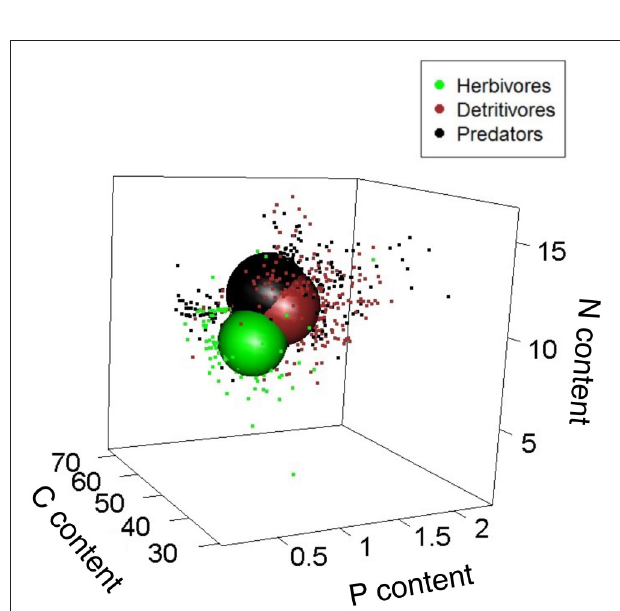
FIGURE 5 | Relative size of stoichiometric niche volumes of trophic groups (only invertebrates included). Sphere sizes depicts the volumes of the various grouping variables, and are centered around the average C, N, and P contents of all individuals from those variables. Dots are individual coordinates and show the variability within a given grouping variable. Axes represent each element as a percentage of dry body mass.